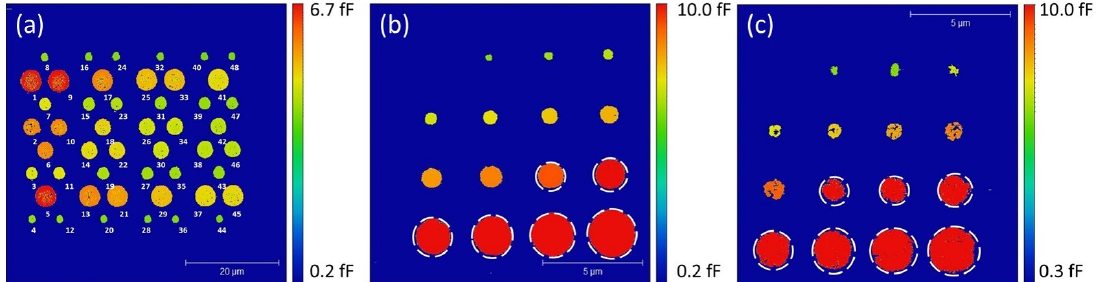
Figure 6. Capacitance maps of the samples at VNA frequency of 3.67 GHz. The circled pads are out of the calibration range. ( a ): A64; ( b ): PZT; ( c ): PMN-PT.